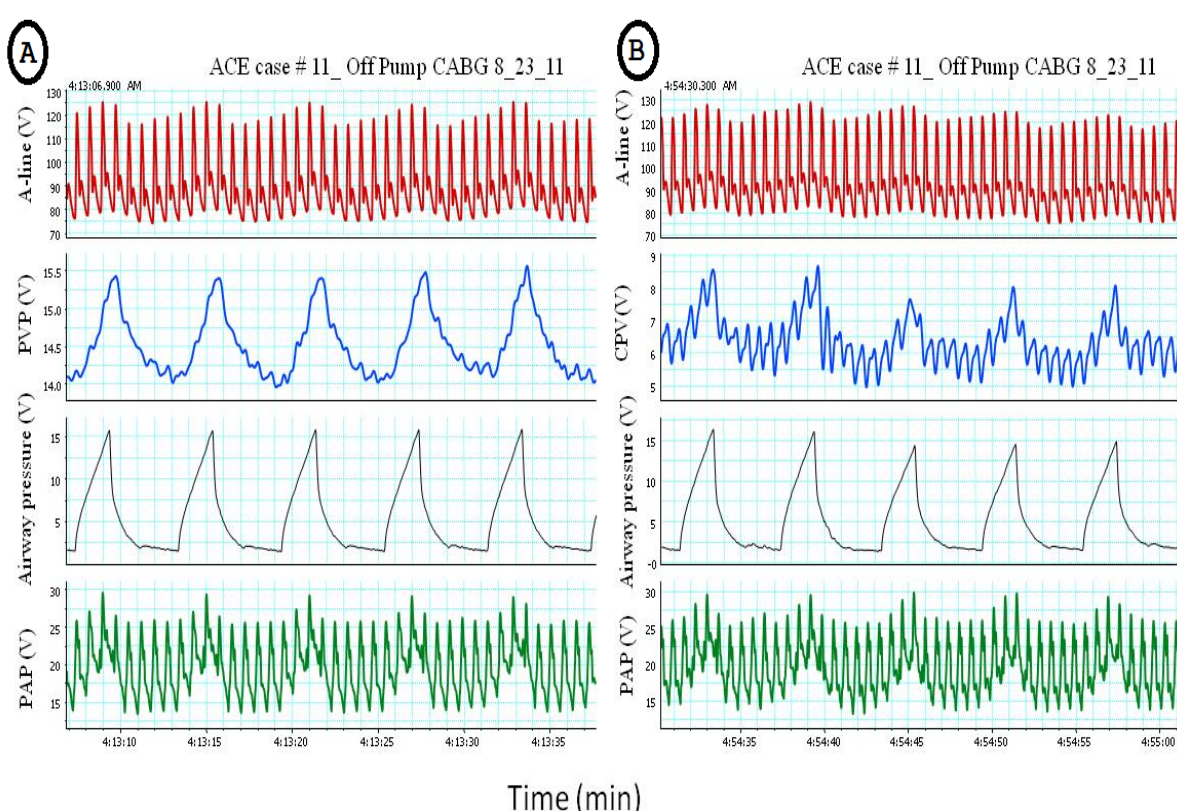
Figure 3. The impact of positive pressure ventilation on arterial pressure, pulmonary artery pressure (PAP), central venous pressure (CVP) and peripheral venous pressure (PVP), notice the transient increase in the arterial pressure(reverse pulsus paradoxus, RPP), PAP, CVP and PVP during the inspiratory cycle of controlled ventilation. Positive pressure ventilation will compress the vena cava and resulted in increased of both PVP ( A ) and CVP ( B